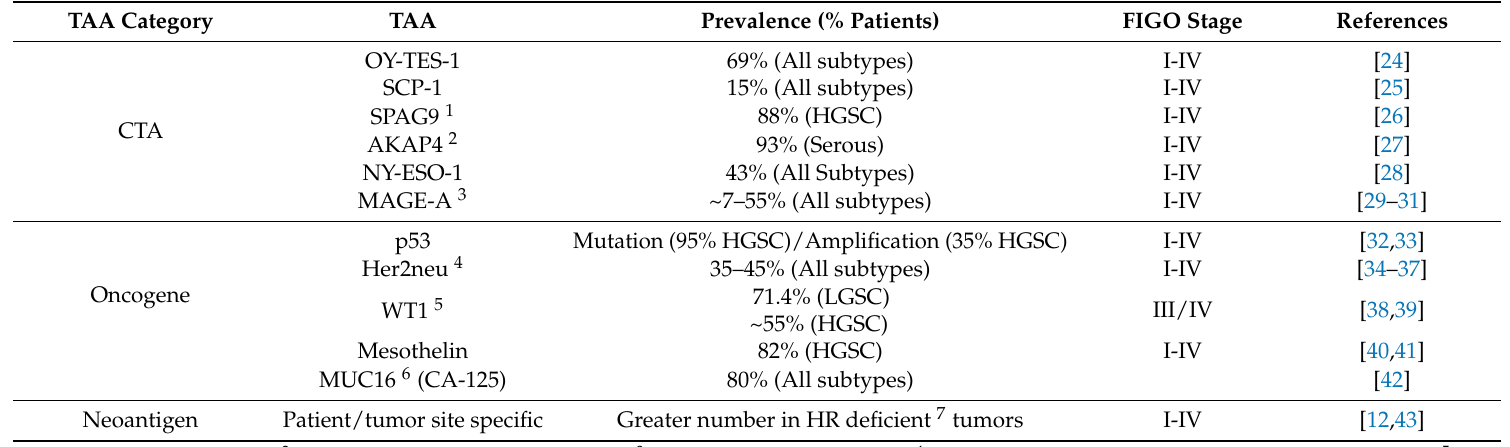
Table 2. Type and prevalence of tumor-associated antigens (TAAs) in